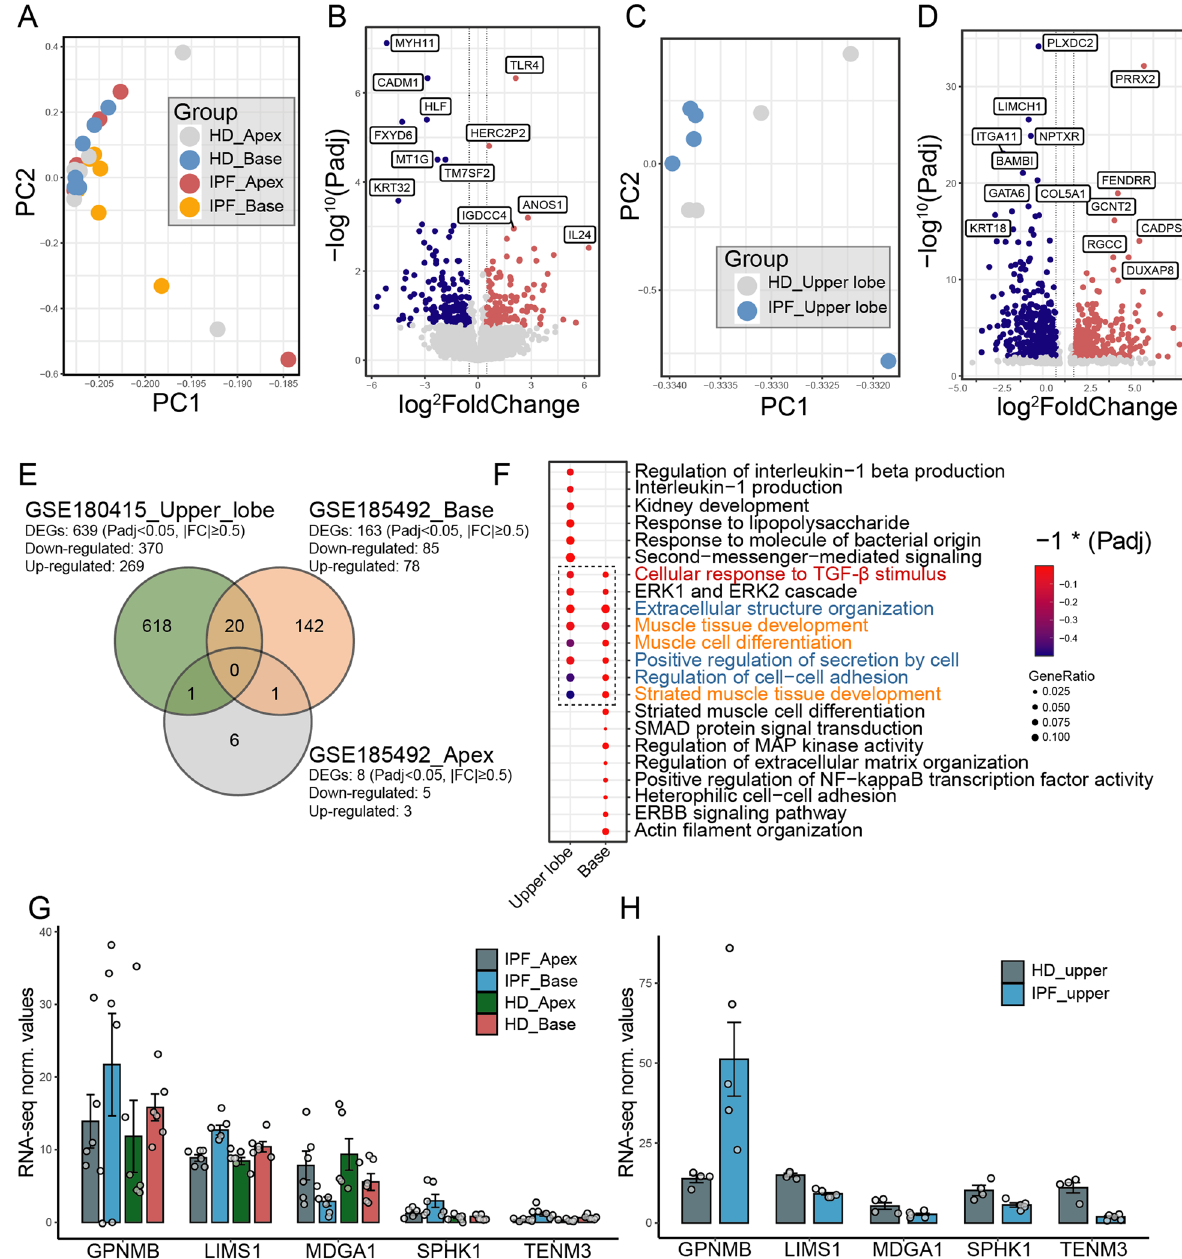
Fig. 2 Identifications of transcriptomic profiles of lung FB samples from patients with IPF and healthy donors (HD). A Principal component analysis on IPF/HD-derived FB samples from the apex (n 12) and basal lung sites (n 12, GSE185492). B Volcano plot displaying identified DEGs in IPF-FB = = compared with HD-FB from the basal lung site (GSE185492) by log2 foldchange (x-axis) and adjust P-value (y-axis). Blue dots represent DEGs significantly down-regulated; red dots represent DEGs significantly upregulated; grey dots represent genes not significantly regulated. C Principal component analysis on IPF/HD-derived FB samples from the upper lobe lung site (n 9, GSE180415). D Volcano plot displaying identified DEGs in = IPF-FB compared with HD-FB from the upper lobe lung site (GSE180415) by log2 foldchange (x-axis) and adjust P-value (y-axis). Blue dots represent DEGs significantly down-regulated; red dots represent DEGs significantly upregulated; grey dots represent genes not significantly regulated. E Venn diagrams depicting the number of DEGs specifically or mutually regulated in IPF-FB samples from different lung anatomical sites. F Enriched analysis by EGO using DEGs identified in IPF-FB samples from upper lobe lung and basal lung sites. G , H RNA-seq expression normalized value (fragments per kilobase of exon model per million mapped fragments, FPKM) for transcripts encode for genes related to response to TGF-β1 stimulus and muscle tissue development in each RNA-seq